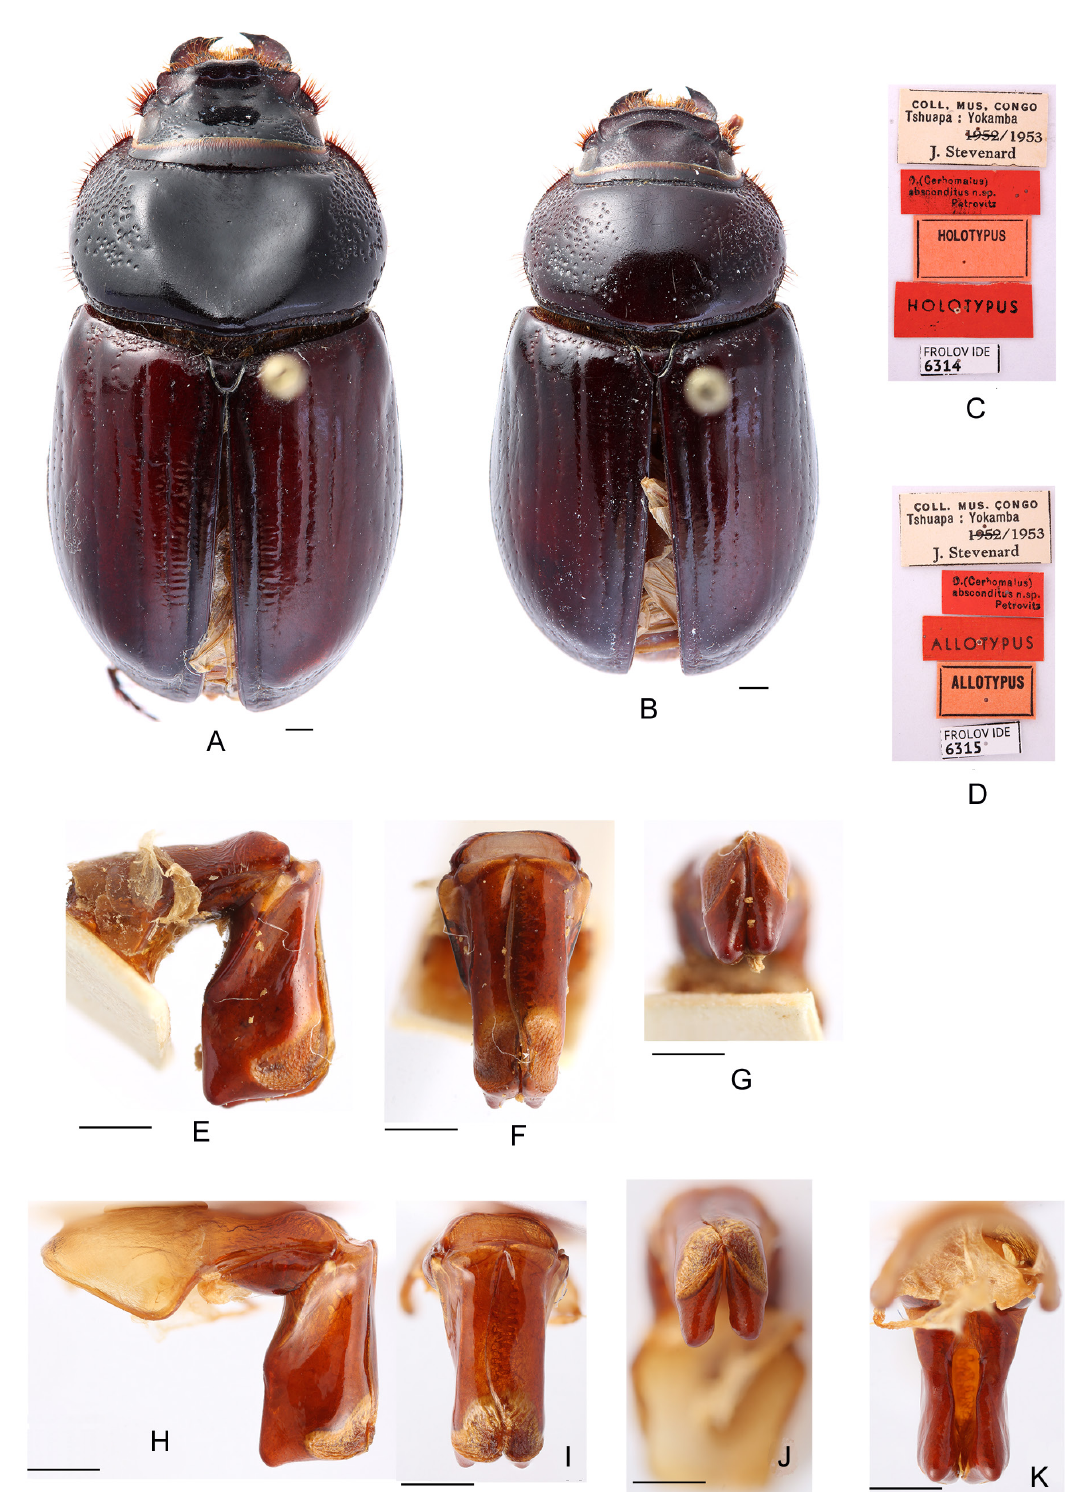
Fig. 2. Cerhomalus absconditus (Petrovitz, 1971). A, C, E–G . Holotype, ♂ (RMCA). B, D . Paratype, ♀ (RMCA). H–K . Male specimen from Andrada, Angola. A–B . Habitus in dorsal view. C, D . Labels. E, H . Aedeagus in lateral view. F, I . Parameres in dorsal view. G, J . Parameres in apical view. K . Parameres in ventral view. Scale bars = 1.0